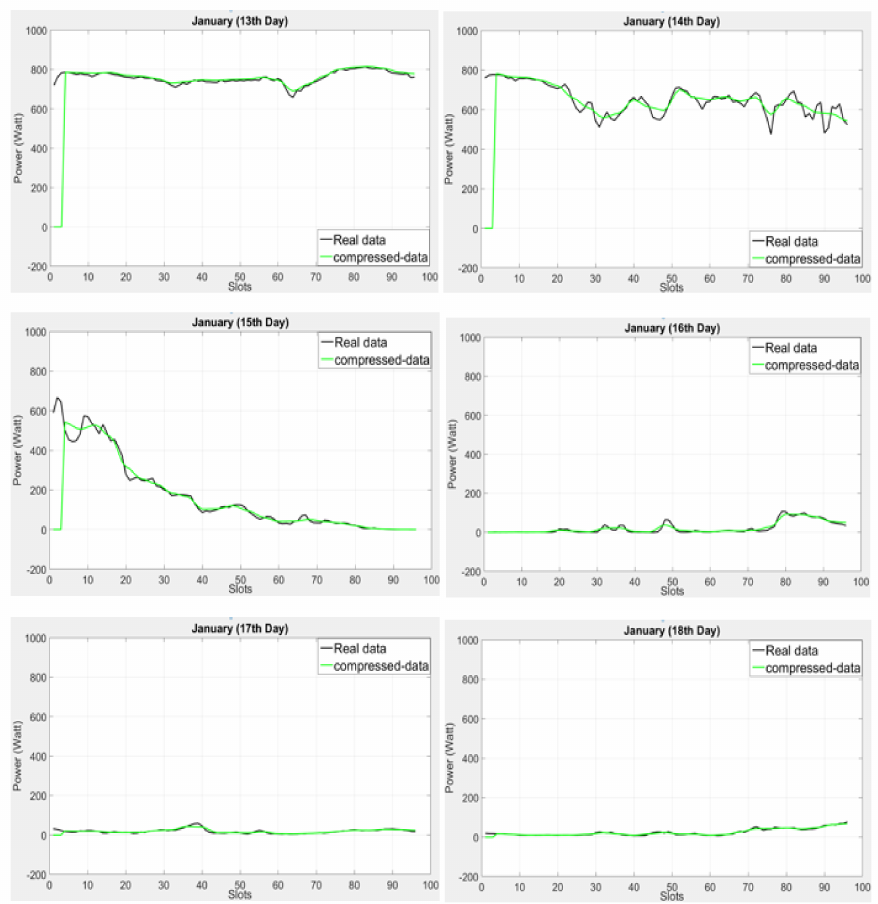
Figure 8. Graphical representation of the compressed profile method against the real data based on the shorter (15-min data interval) time period horizon of wind profile (Elia) with 96 time slots in 24